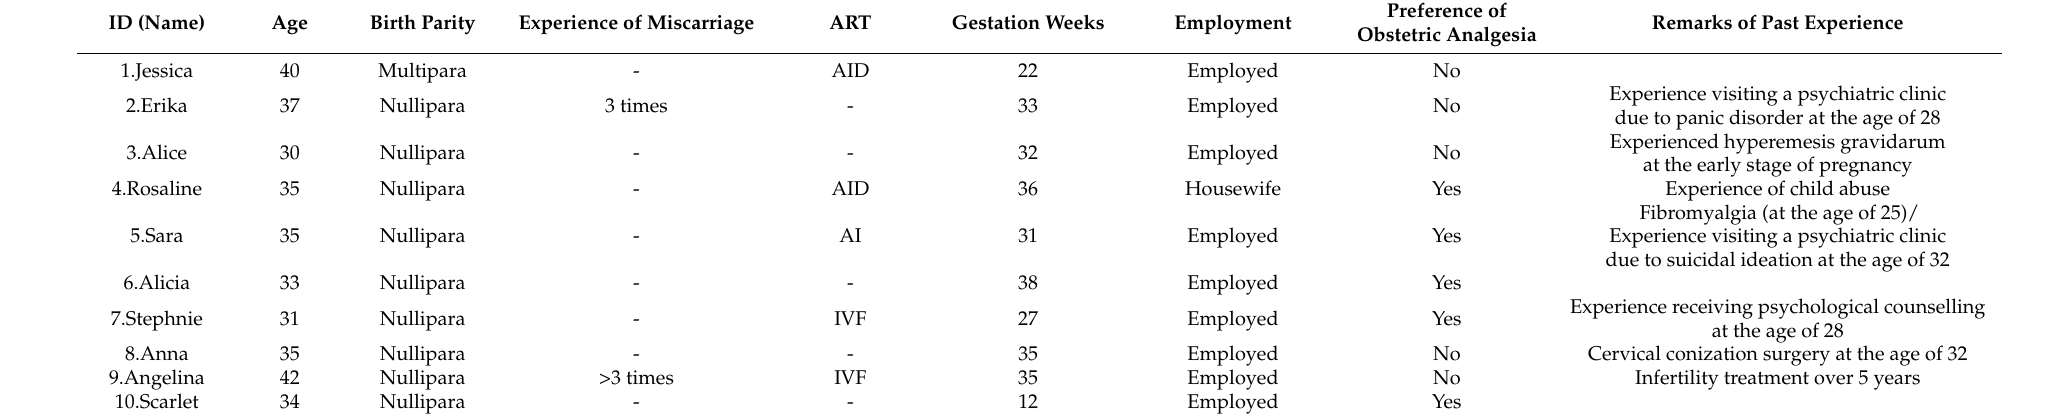
Table 1. Participants’